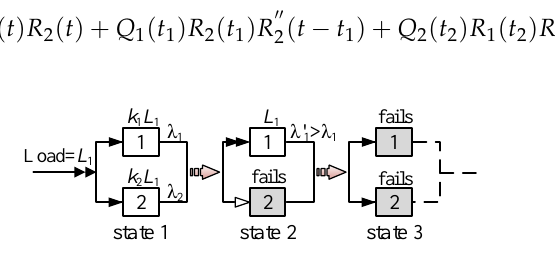
Figure 7. Load-sharing with two redundant components ( k 1 + k 2 = 1 )